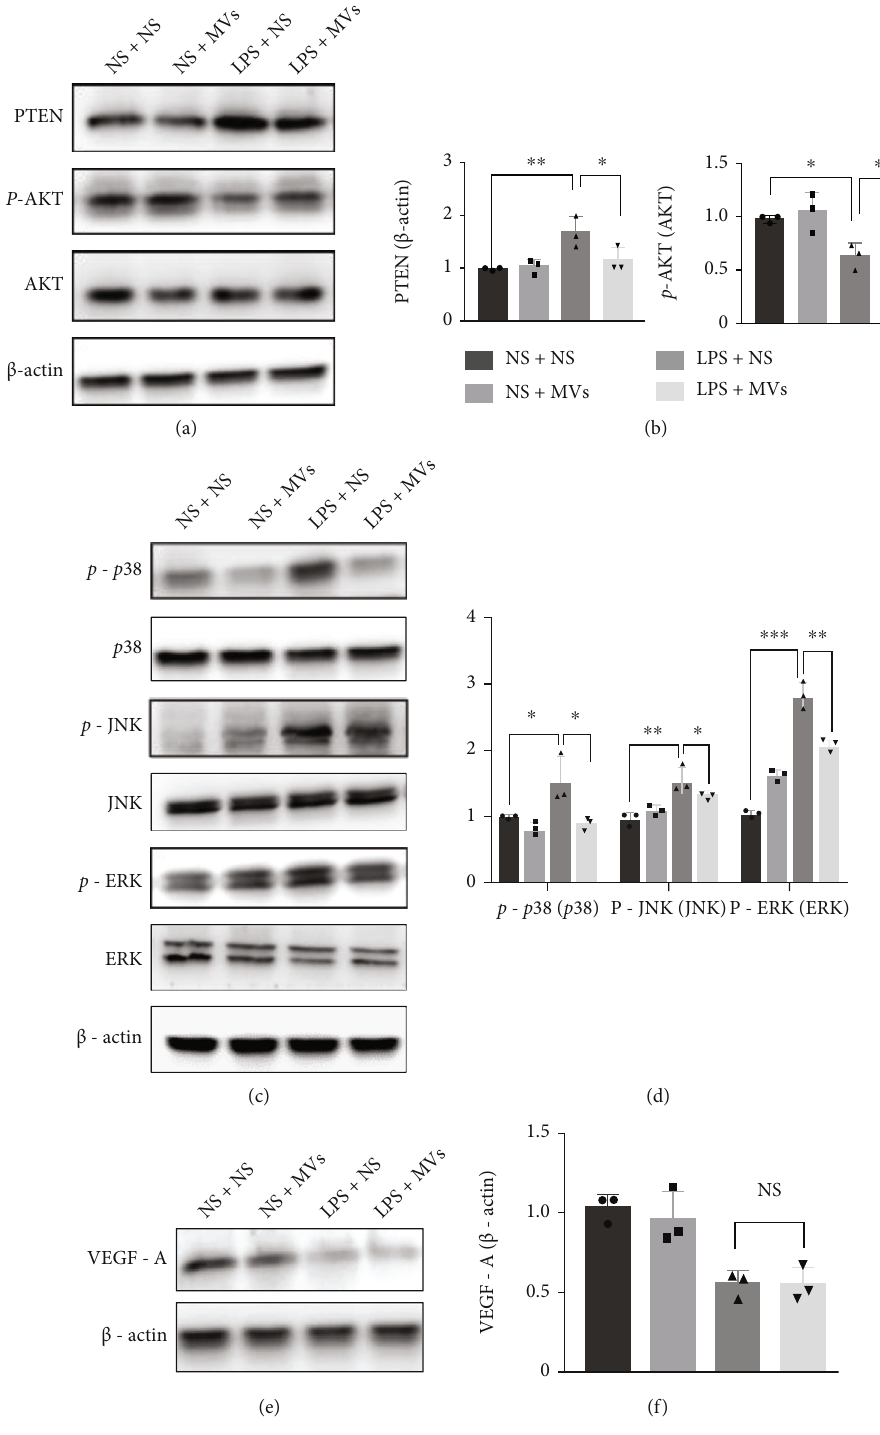
Figure 9: MVs activate the PTEN/p-AKT pathway and suppress the MAPK pathway in the IA-LPS BPD model. (a) The protein levels of PTEN, p-AKT at S473, and AKT were evaluated by western blotting on lung homogenates on PN14. (b) Densitometric analysis was used to quantify the expression of PTEN and p-AKT/AKT ( N = 3 , ANOVA, ∗∗ P < 0 : 01 and ∗∗∗ P < 0 : 001 ). (c) The protein levels of p38, JNK, ERK, and their phosphorylated forms (p-p38, p-JNK, and p-ERK) were evaluated by western blotting on lung homogenates on PN14. (d) Densitometric analysis was used to quantify the phosphorylation of p38 at Thr180/Tyr182, JNK at Thr183/Tyr185, and ERK1/2 at Thr202/Tyr1204 ( N = 3 , ANOVA, ∗∗ P < 0 : 01 and ∗∗∗ P < 0 : 001 ). (e) The protein levels of VEGF-A in lung homogenate were evaluated by western blotting on PN14. (f) Densitometric analysis was used to quantify the expression of VEGF-A ( N = 3 , ANOVA, NS: not signi fi cant, ∗∗∗ P < 0 : 001